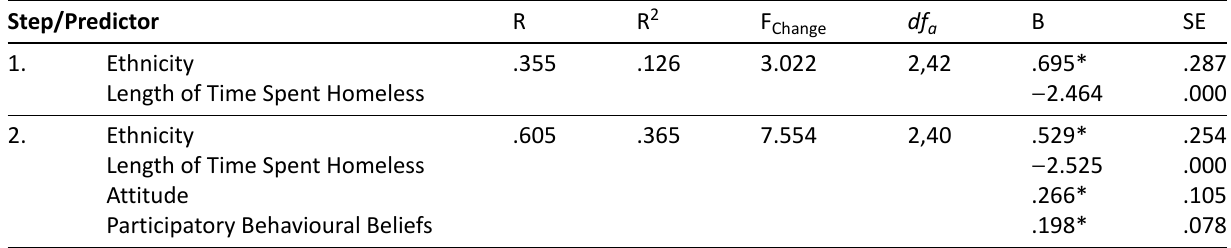
Table 3. Hierarchical multiple regression analysis predicting future service use intentions. Step/Predictor